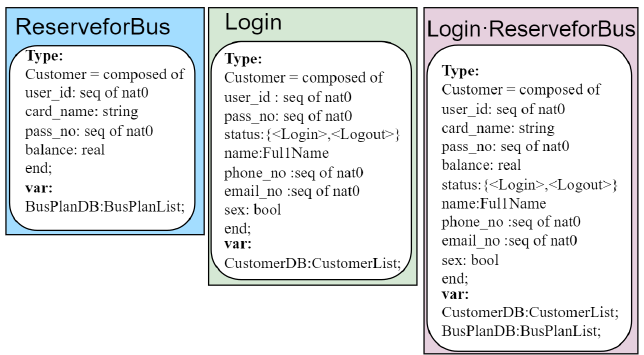
Figure 10. Declaration integration of feature pair.